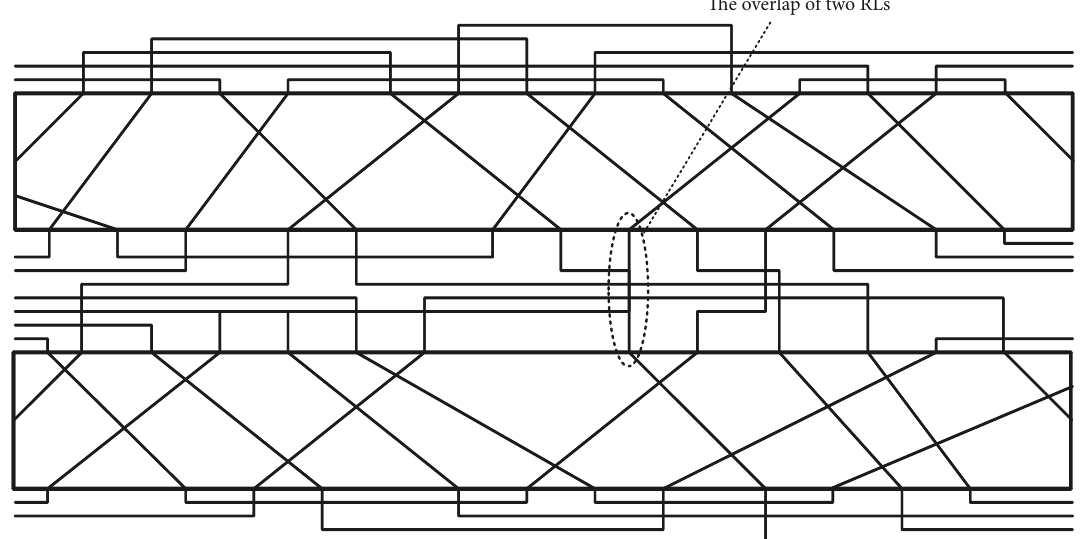
Figure 7: Locomotive working diagram generated using the smallest distribution method.